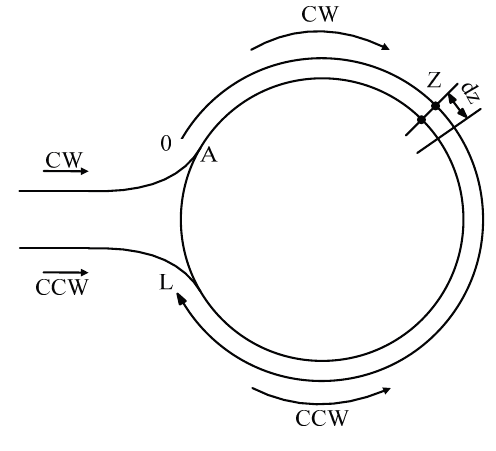
Figure 1. Curves for temperature of fiber loops and IFOG output.